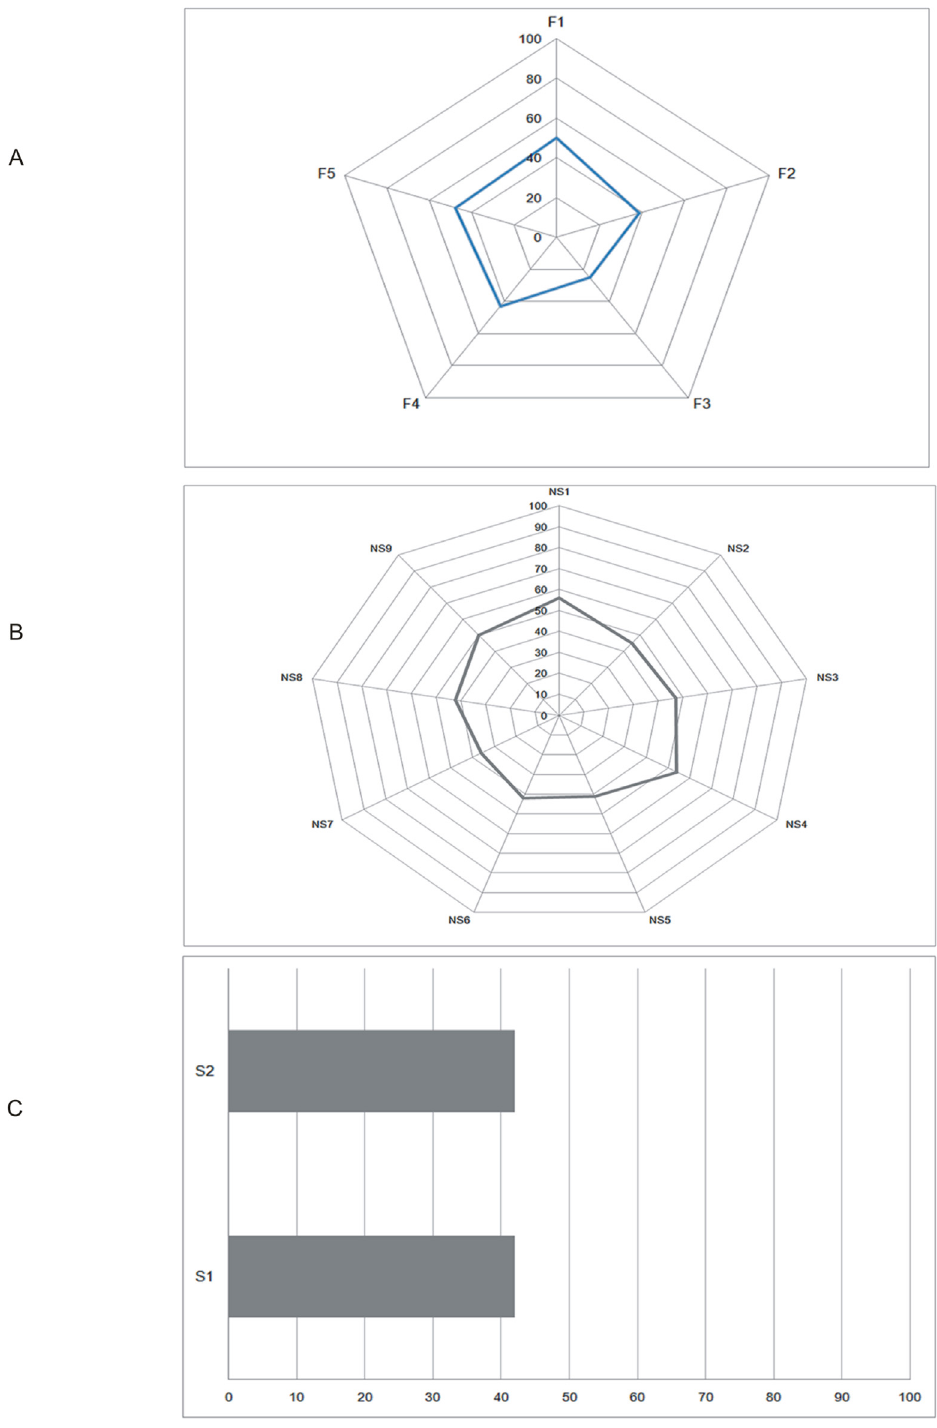
Fig 2. Disaster safety score in terms of A) functional capacity, B) non-structural safety, and C) structural safety in 421 of Iran ’ s hospitals,